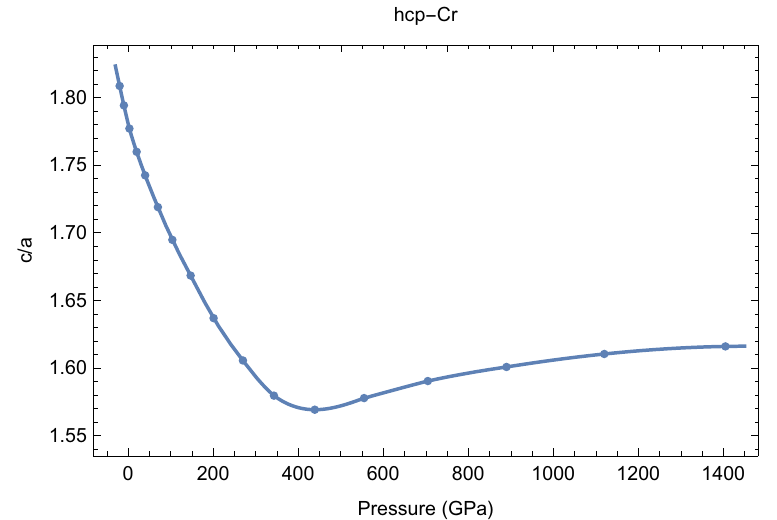
Figure 3. The P -dependence of the c / a ratio for the lattice constants of the hcp-Cr unit cell.